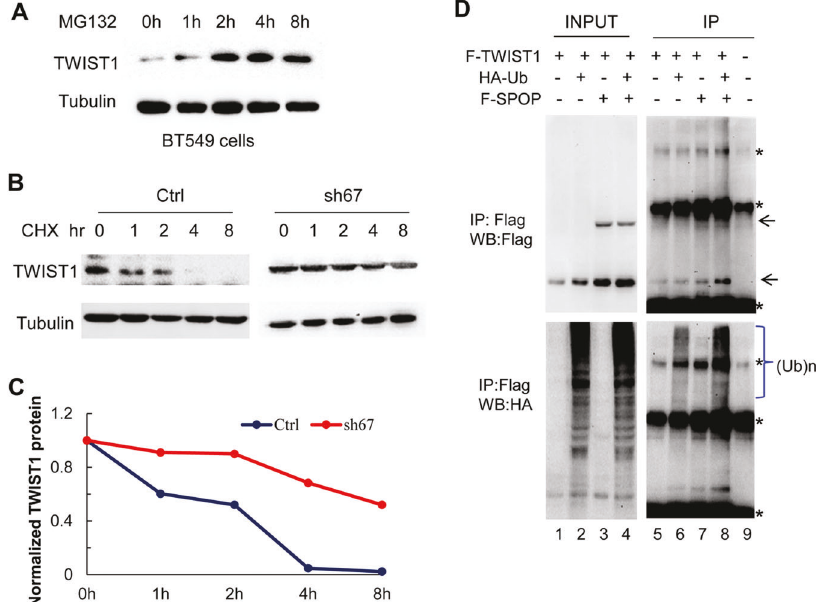
Fig. 4 SPOP ubiquitinates TWIST1 and destabilizes it. A MG132 stabilizes TWIST1. B Knock-down of SPOP prolongs the half-life of TWIST1 protein. Cell lines transfected with shCtrl or shSPOP (sh67) vectors were treated with 20 µg/ml CHX and whole protein lysates were collected at the indicated times for western blotting. C TWIST1 protein level was quanti fi ed and plotted relative to the 0-time point. D SPOP ubiquitinates TWIST1. HeLa cells with transient overexpression of indicated either HA-Ubiquitin (UA-Ub), FLAG-SPOP (F-SPOP), FLAG-TWIST1 (F-TWIST1) or combination were harvested and subject to M2 beads immune-precipitation (IP: FLAG) and western blotting with indicated